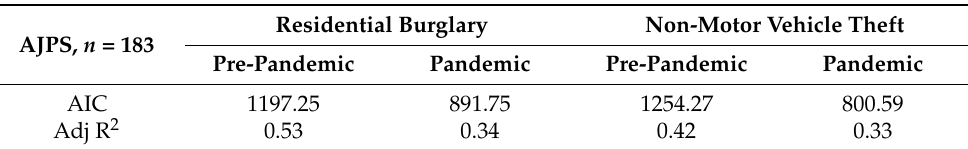
Table 6. AICs and Adj R 2 s derived from GWR regression to residential burglary and non-motor vehicle theft during the pre- and pandemic periods.